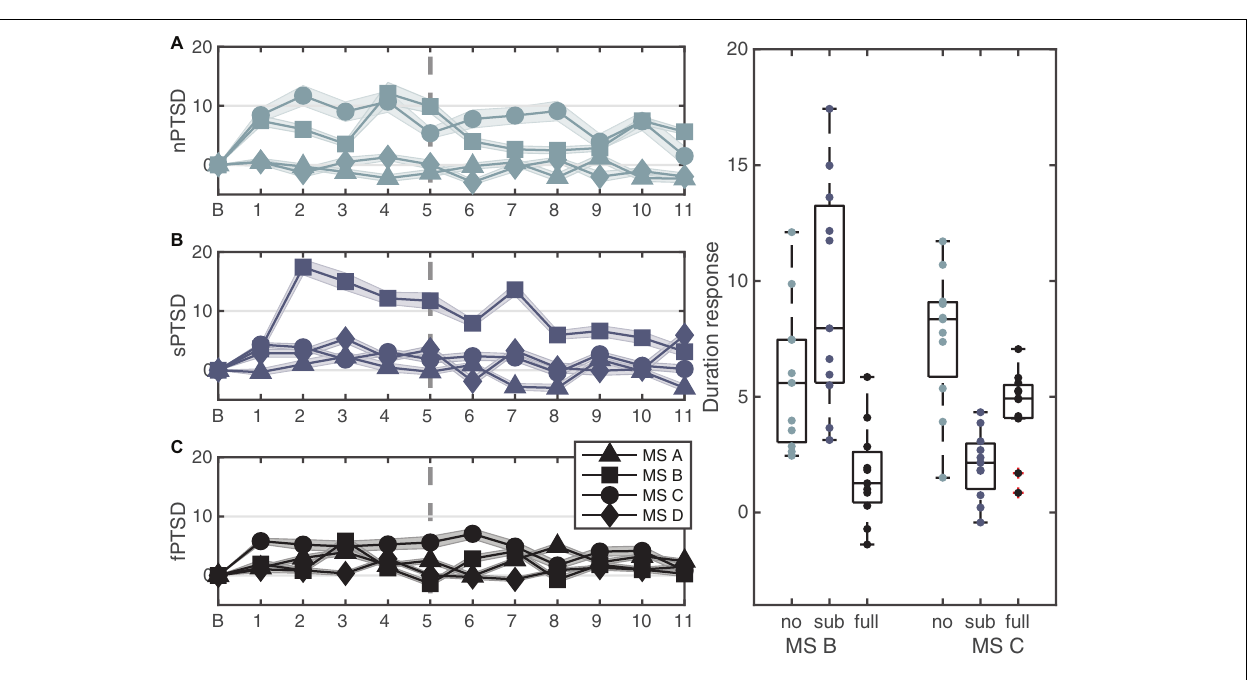
for the fPTSD group ( p = 0.00743) and for the sPTSD group ( p < 0.0001). The duration response for the fPTSD group is also significantly higher than the sPTSD group ( p =